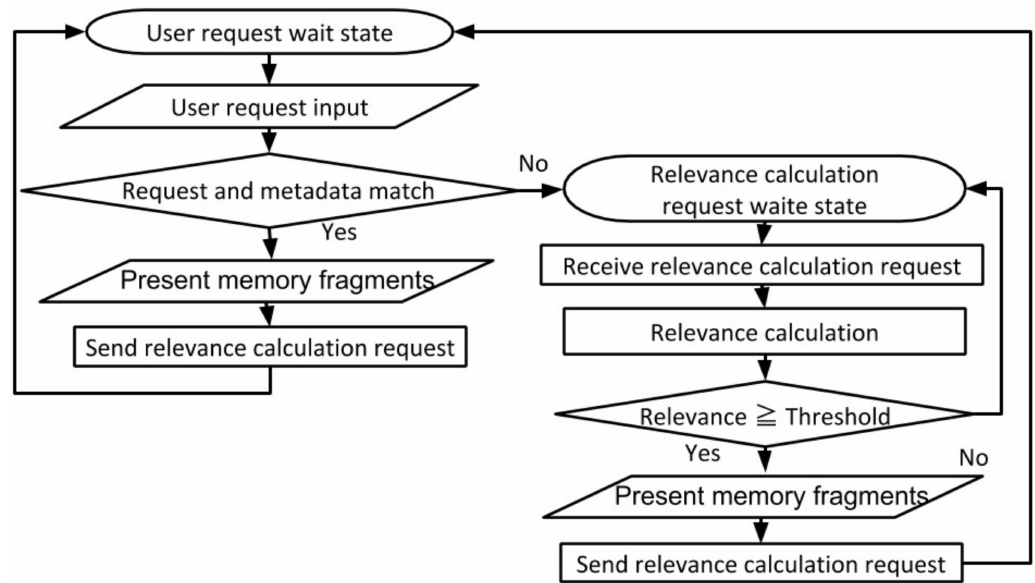
Figure 6. Flowchart of memory fragment recall in an